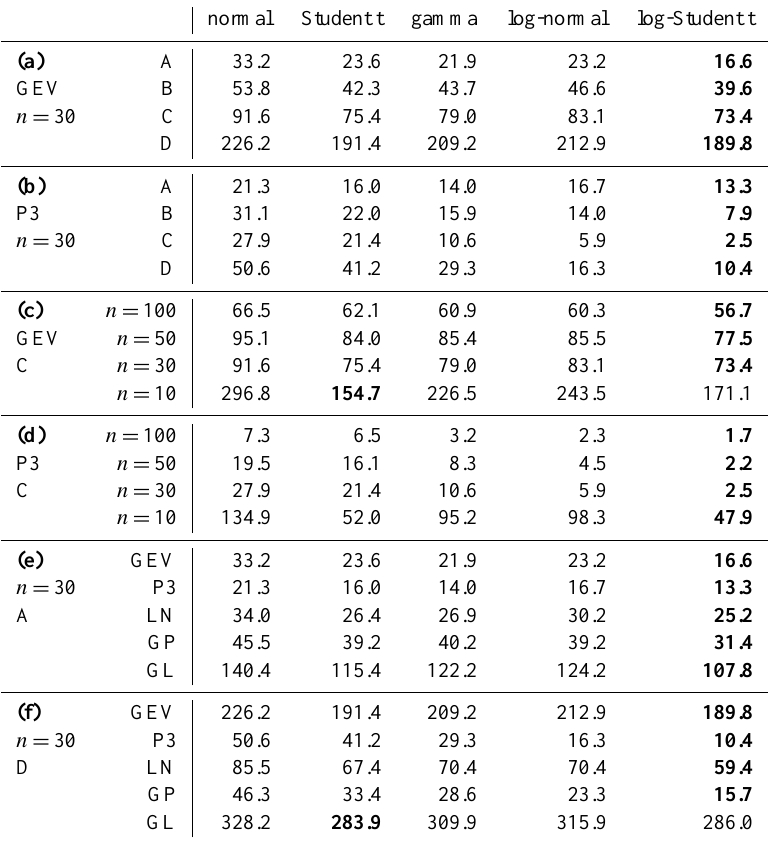
Table 1. Anderson-Darling statistic of discrepancy between the CDF of 10000 values of P(τ) and the uniform distribution U . The columns show the value of the statistic for the five candidate distributions with parameters corrected by Eqs. (16) and (17). The best fit is indicated by the bold font. Different situations are considered: (a) GEV parent distributions with different asymmetry (point A, B, C, D of Fig. 1); (b) P3 parent distributions with different asymmetry; (c) GEV parent distribution and samples of different length n ; (d) P3 parent distribution and samples of different length n ; (e) different parent distributions with low asymmetry (point A); (f) different parent distributions with high asymmetry (point